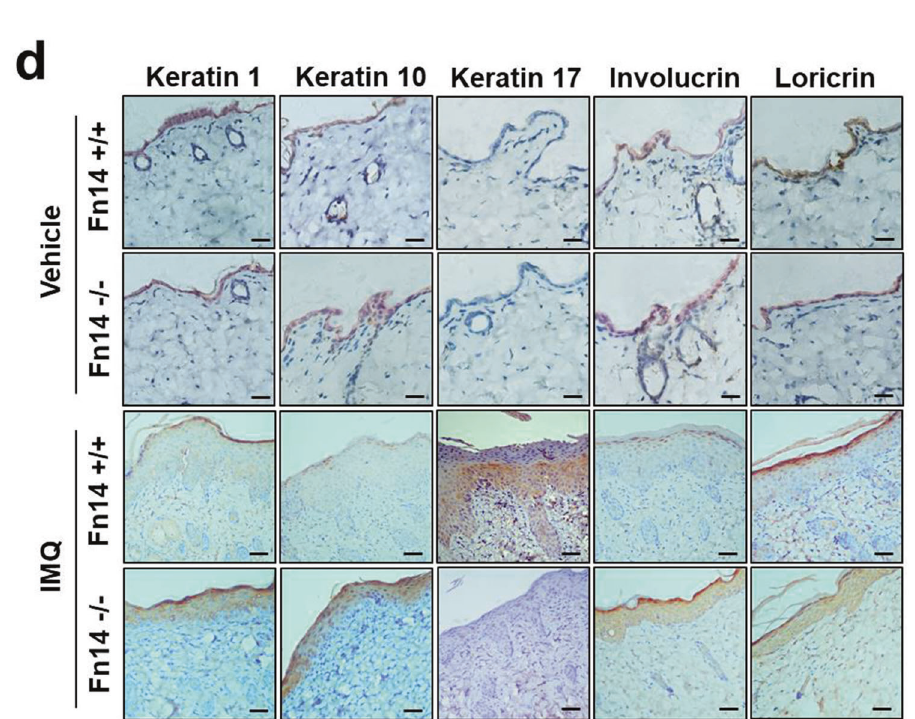
Cell Death and Disease (2023)